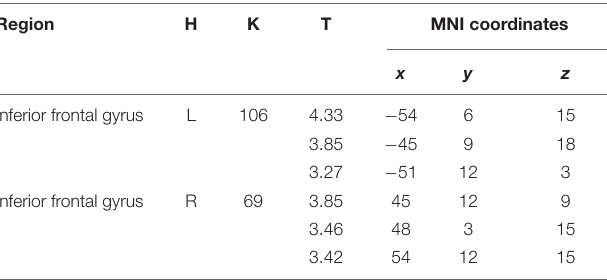
TABLE 3 | Results of voxel-wise functional connectivity. Region